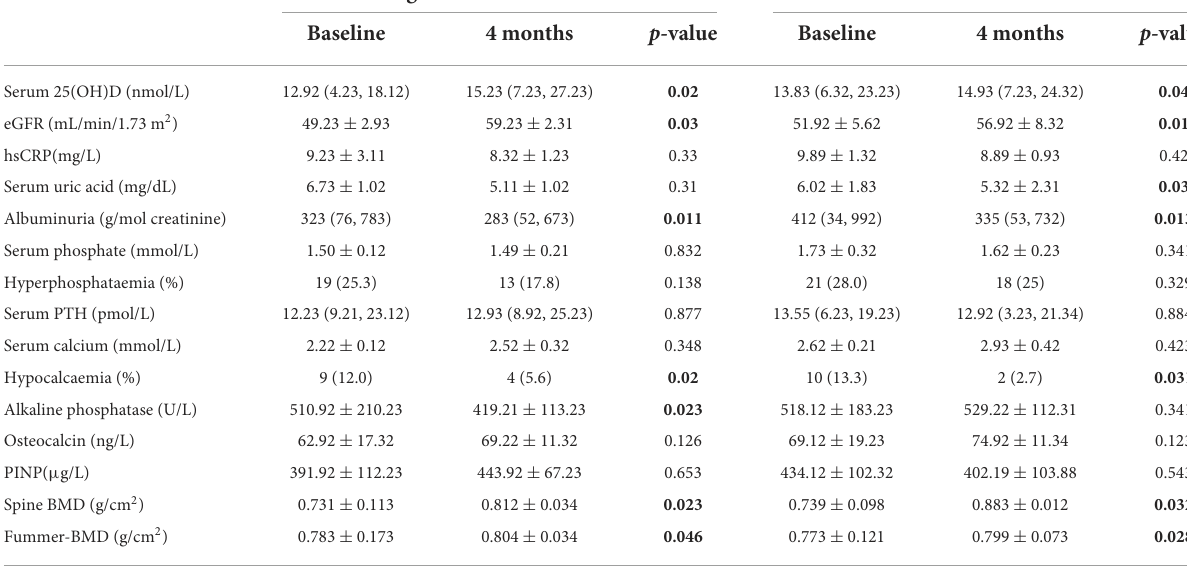
TABLE 3 Changes in biochemical parameters of the high dose and standard dose of vitamin